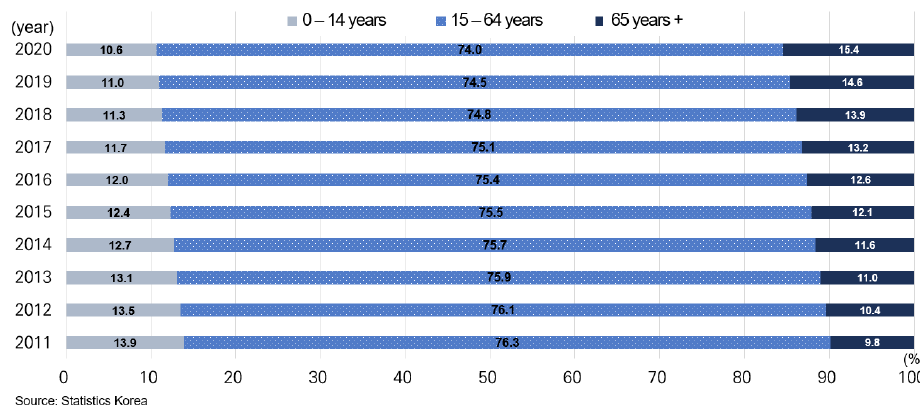
Figure 2. Population proportion by age group in Seoul.